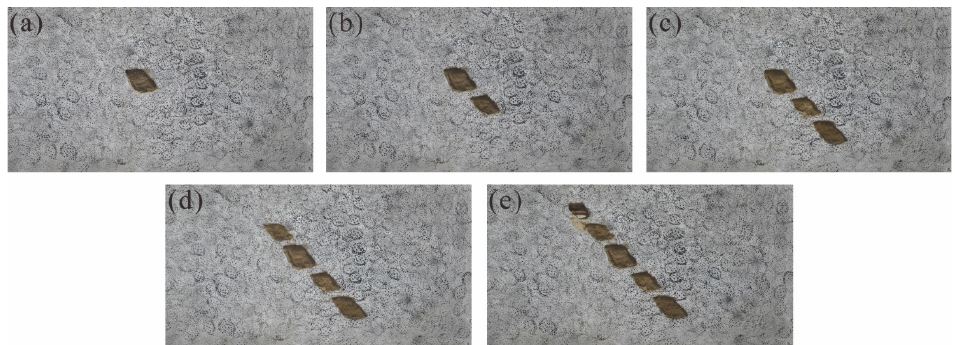
Figure 3. Physical model of the test process. ( a ) Mining and filling between − 200 m and − 165 m; ( b ) mining and filling between − 240 m and − 205 m; ( c ) mining and filling between − 280 m and − 245 m; ( d ) mining and filling between − 160 m and − 125 m; ( e ) mining and filling between − 120 m and − 85 m.